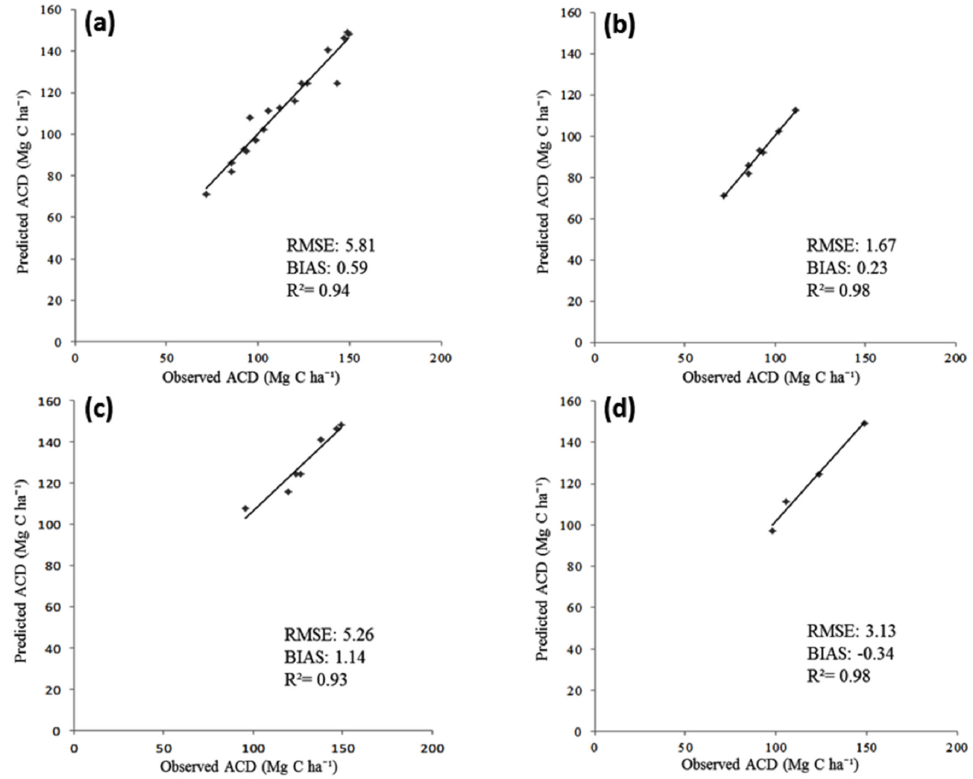
Figure 3. ( a ) Validation of the general ACD model in eighteen independently 1-ha plots. The performance of the general model is shown for topographic position at ( b ) valley; ( c ) ridge including plot with remnant of secondary forest; and ( d ) slope. RMSE = root mean squared error, BIAS = mean errors. Our results strongly suggest that the spatial arrangement of forest carbon stocks, based on topographic location, influences the accuracy of estimates of ACD in western lowland Amazonian mature forest achieving an overall accuracy of 5% at 1-ha resolution (RMSE = 5.81 Mg·C·ha − 1 relative to forest carbon density of ~120 Mg·C·ha − 1 ). The model validation for ACD estimation in ridge positions (Figure 3c) indicated higher bias and RMSE compared with the other topographic positions because these areas include the plot with remnant of secondary forest. Secondary forest growth is higher than adjacent mature forest on ridges where the growth is minimal [51], affecting the estimation of the model